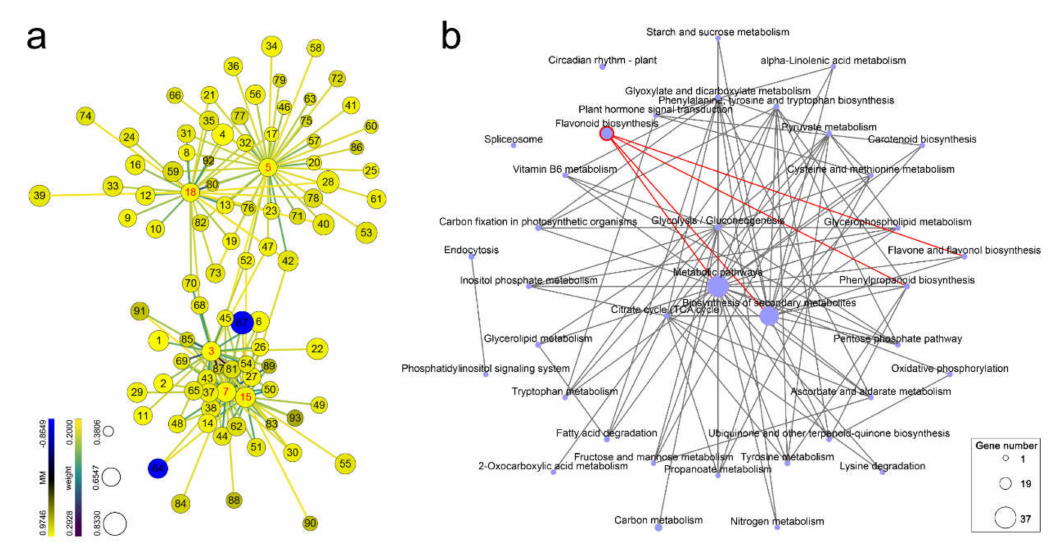
Figure 7. Gene network for chalcone synthase genes in the yellow module. ( a ) Coexpression network for chalcone synthase genes (weight value > 0.2, detailed in Table S15). Prefuse force directed layout was applied based on the weight value between two genes. The size of the nodes represents the gene significance for the nematode population (from 0.3806 to 0.8330). The color of the nodes represents module membership (from − 0.8649 to 0.9746). The colors of the lines represent the weight value between two genes (from 0.2000 to 0.2928). The labels on the nodes are based on intramodular connectivity (from 6.1505 to 56.6806). The chalcone synthase genes are highlighted with red labels; ( b ) KEGG enrichment network. The nodes represent KEGG pathways, and the node size represents the number of genes enriched in the pathway by KEGG enrichment analysis. The pathways that chalcone synthase genes were enriched in are highlighted with red